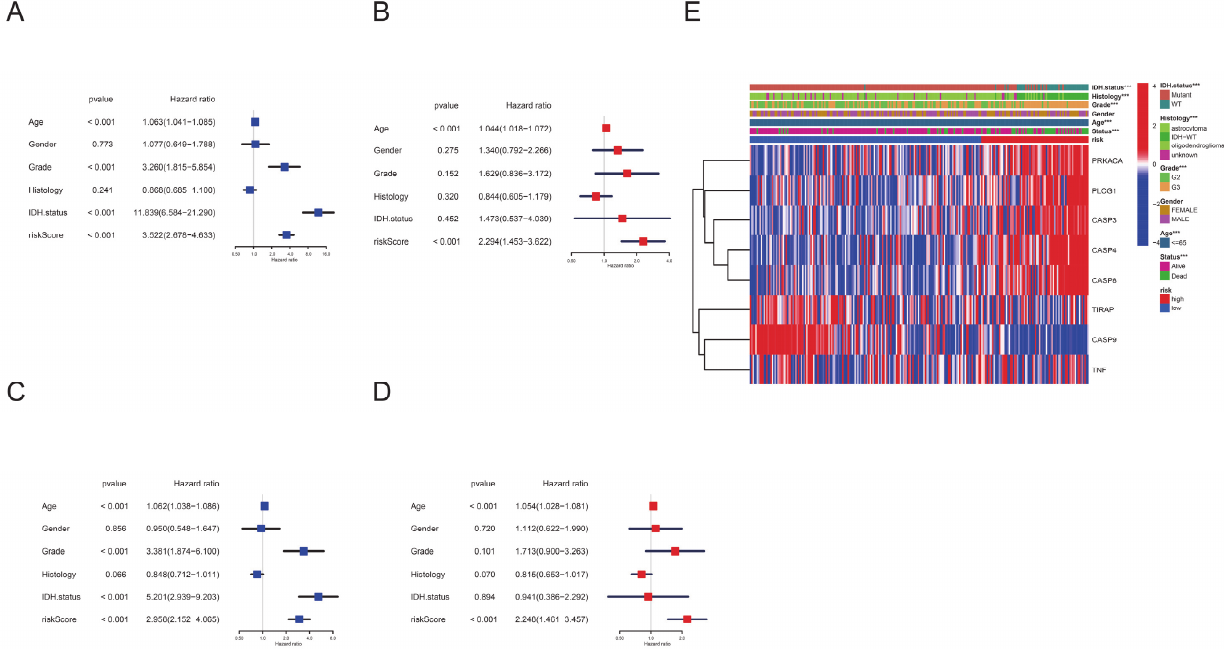
Figure 5. Univariate and multivariate Cox regression analyses for PyroScore. ( A ) Univariate analysis for the TCGA training cohort. ( B ) Multivariate analysis for the TCGA training cohort. ( C ) Univari- ate analysis for the TCGA validation cohort. ( D ) Multivariate analysis for the TCGA validation cohort. ( E ) Heatmap showing the association between clinical characteristics and the risk groups (*** p <